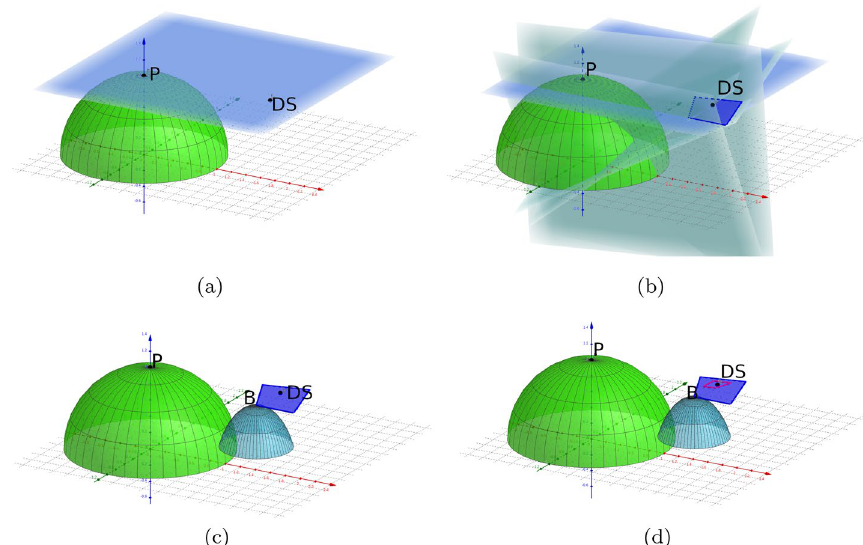
Fig. 2 3D illustration of random hyperplane tessellation for the first example of intuitive